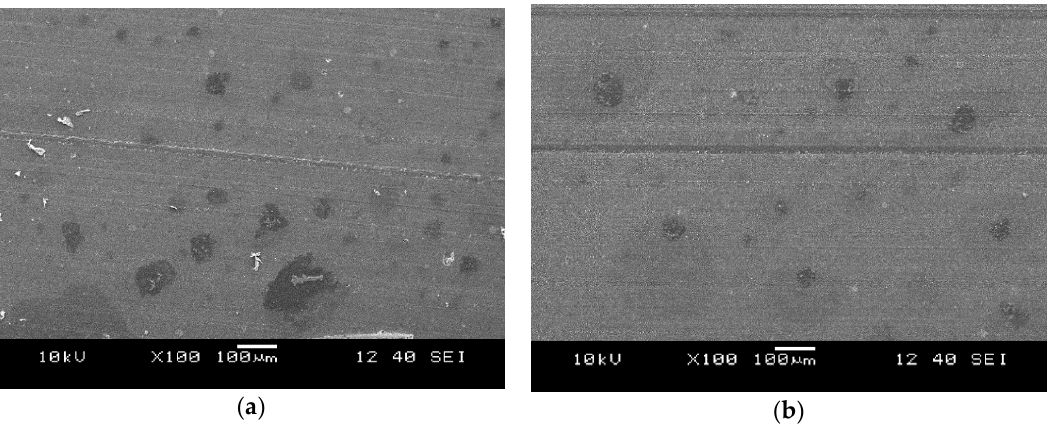
Figure 10. Cryomicrotomed surfaces of the TDVs with different PP feeding methods and higher compounding temperature profile: ( a ) Side feeding with 180 °C melt temperature ( A_S_H_2_50 compounding temperature profile: ( a ) Side feeding with 180 ◦ C melt temperature (A_S_H_2_50 MR); MR) ; ( b ) Hopper feeding ( A_H_H_0_50 MR).